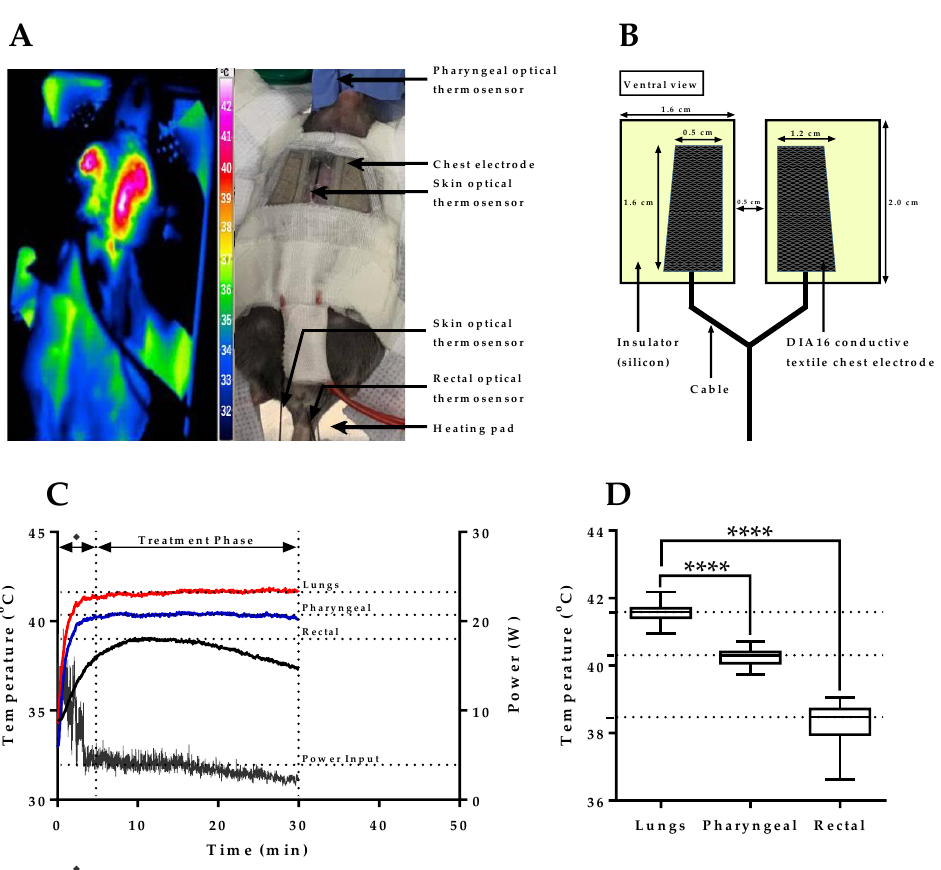
Figure 1. Localization of heat stress during targeted mEHT treatment of lungs. ( A ) Thermal image depicting localized increase in temperature over target area on mice thorax ( left panel) and treatment layout with the positioning of chest electrode and optical thermosensors ( right panel); ( B ) Dimensions of DIA16 conductive textile chest electrode for targeted lung treatment of tumors in mice; ( C ) Plot depicting temperature profiles of lungs, pharynx, and rectum with applied power settings during pilot experiment; ( D ) Pharyngeal and rectal temperature versus lung temperature in treatment phase ( n = 4). Data represent average ± SEM. Mann–Whitney test, **** p < 0.0001.